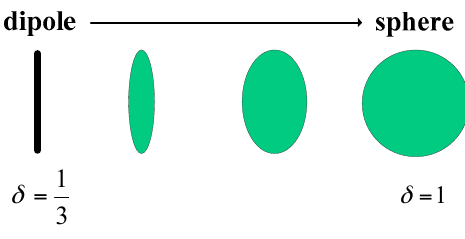
Figure 2. Varying the shape parameter δ